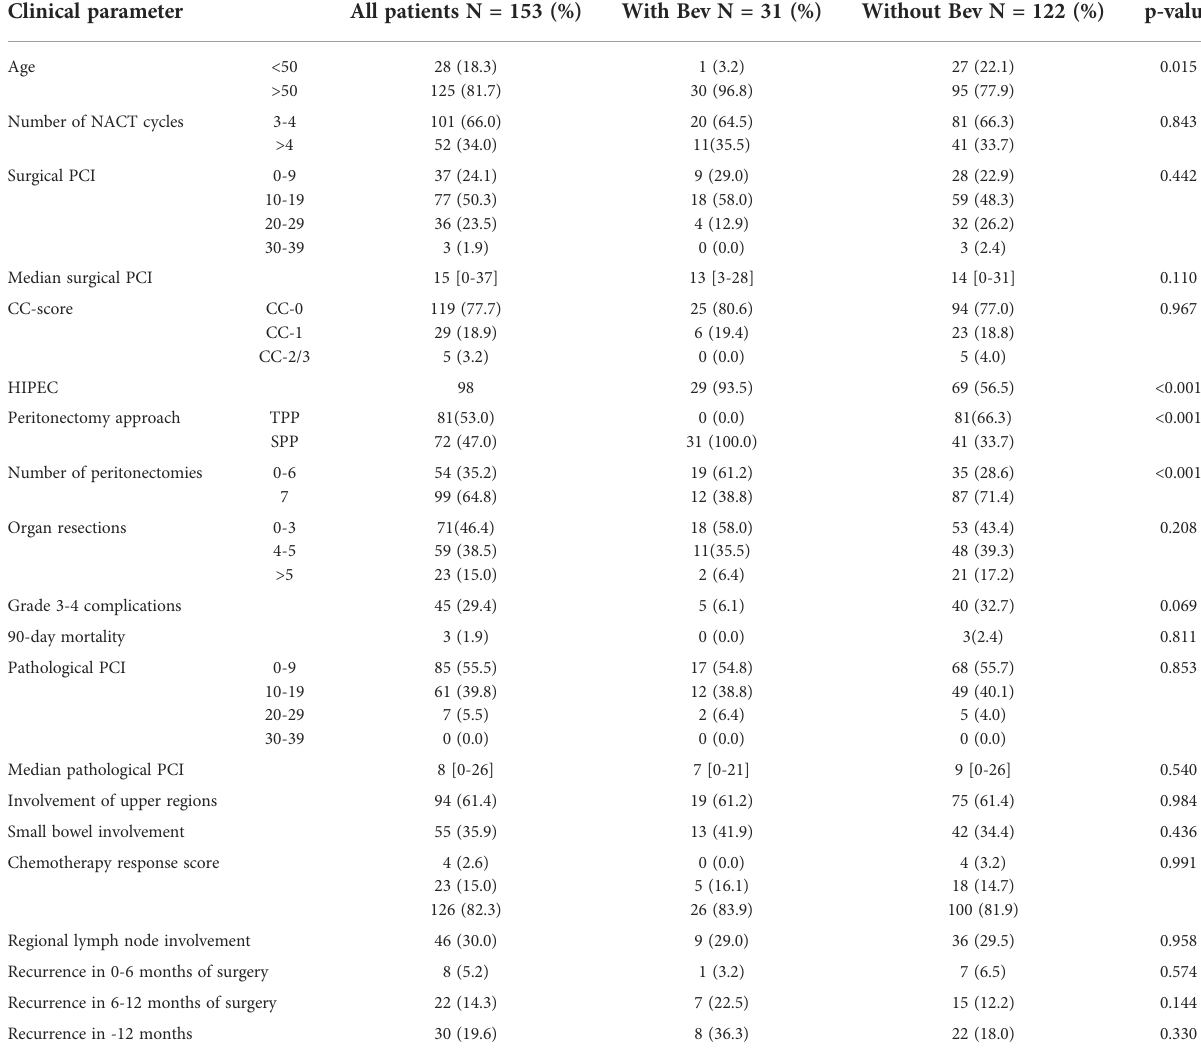
TABLE 6 Comparison between patients treated with and without bevacizumab.